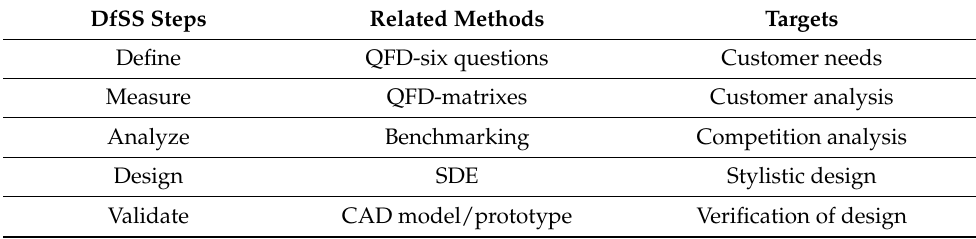
Table 1. DFSS structure and related methods